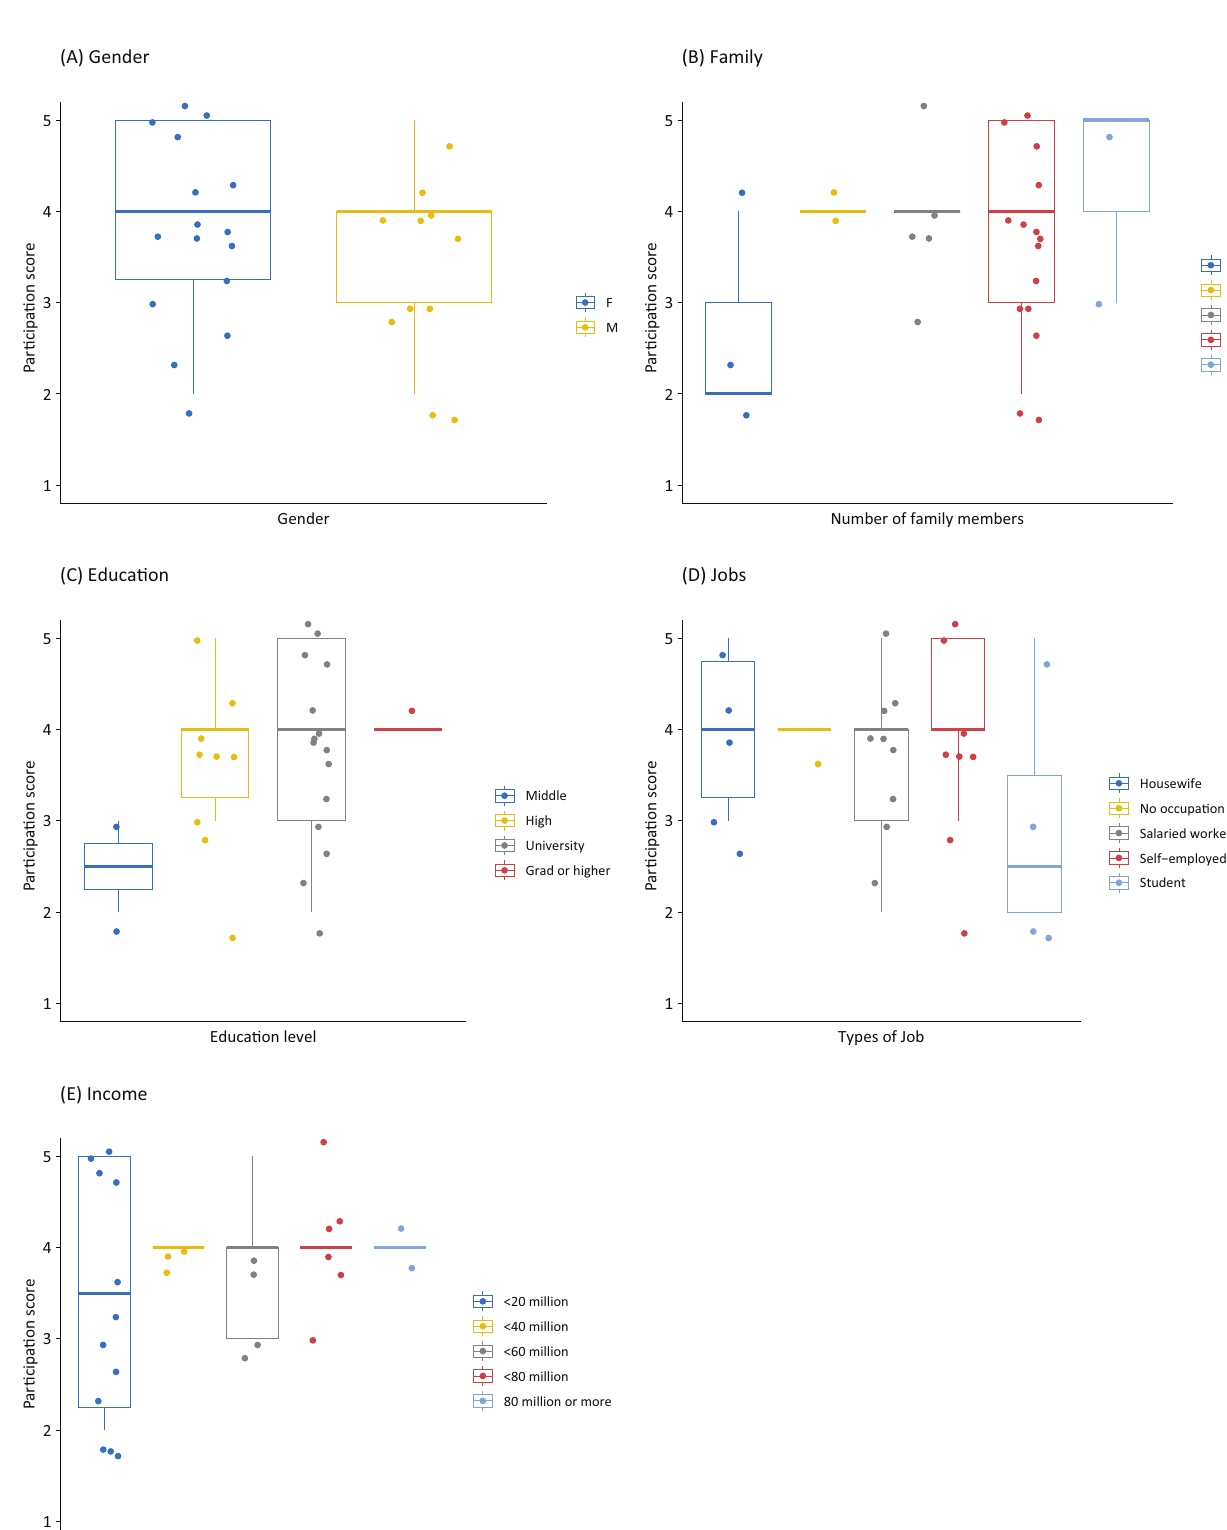
Figure 4. Participation scores by participants’ demographic characteristics and socioeconomic status: (a) sex, (b) number of family members, (c) education level, (d) types of jobs, and (e) average annual income.